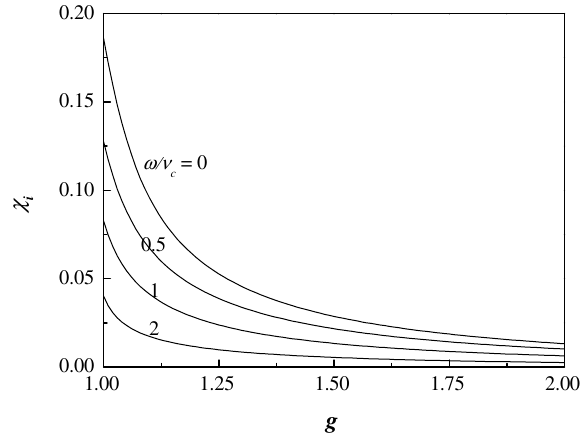
FIG. 1. Plots of the normalized growth rate 2 the geometrical factor g obtained from Eqs. (35)–(37) for several values of the frequency ratio !=(cid:7) (cid:1) 0 and f m